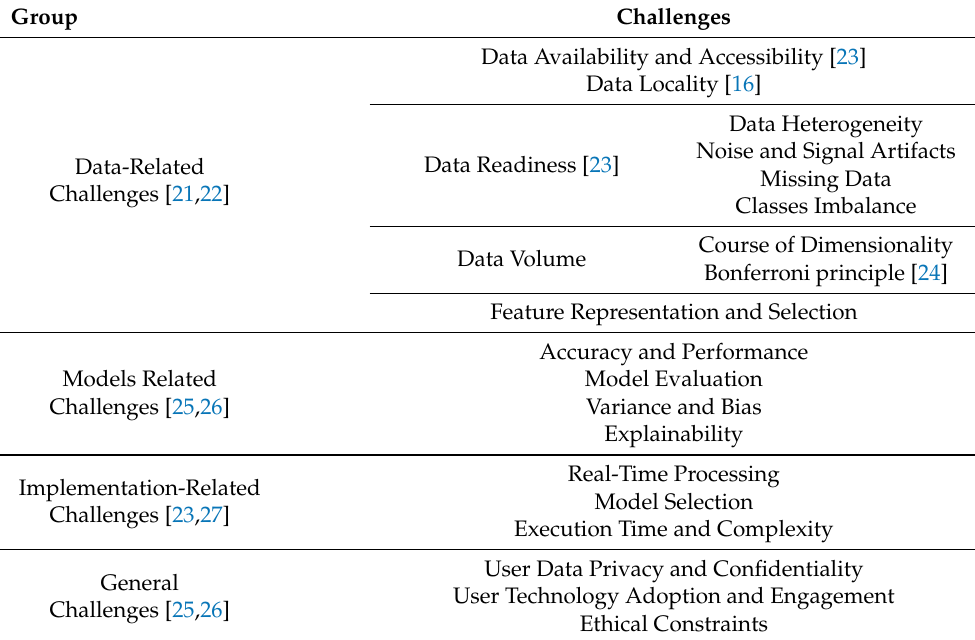
Table 1. Machine Learning domain common